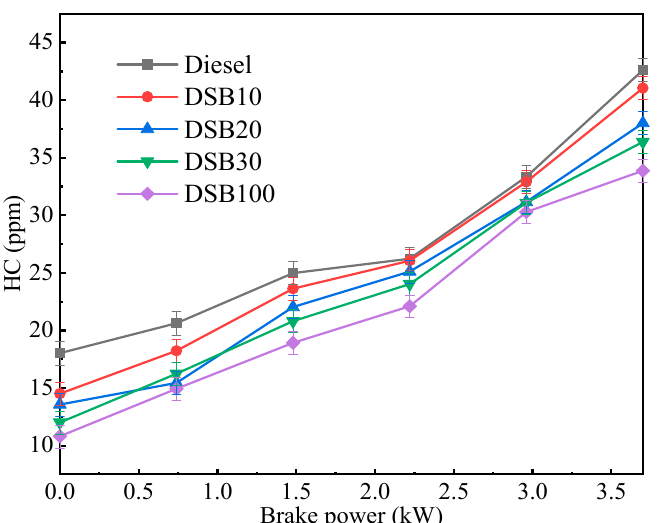
Figure 30. HC emission comparison of biodiesel blends and diesel under different brake powers [191]. In addition, Arunkumar et al. [185] observed an 8.9% reduction in HC emissions from the B20 blend. They explained that eminent CN leads to better combustion due to its ox ‐ ygenated nature, thus reducing HC emissions. Chandra Sekhar et al. [212] used biodiesel produced from Pithecellobium dulce methyl esters (PDSOME) and studied the engine performance and emissions of biodiesel blends. The percentage of reduction in the HC emissions was observed to be 17.64%, 23.52%, 26.47%, 29.41%, and 33.82%, respectively, for PDSOME20, PDSOME40, PDSOME60, PDSOME80, and neat PDSOME compared to diesel fuel at full load. They explained that 9.41% oxygen substance in PDSOME leads to greater flame speed and post ‐ flame oxidation throughout the air–fuel interaction process. Viswanathan et al. [196] pointed out that the HC emissions of diesel at full load were 118 ppm, while 60 ppm was with the 50% ratio of biodiesel. Lower HC emissions due to high in ‐ cylinder temperature lead to more HC oxidization. Ge et al. [149] observed that the HC emissions of B100, B10, B30, and B50 were 402 ppm, 470 ppm, 466 ppm, and 450 ppm, respectively, at 1800 rpm. The reduction in HC emissions with the increase in biodiesel ratio due to oxygen present in biodiesel promotes more combustion in the blends.